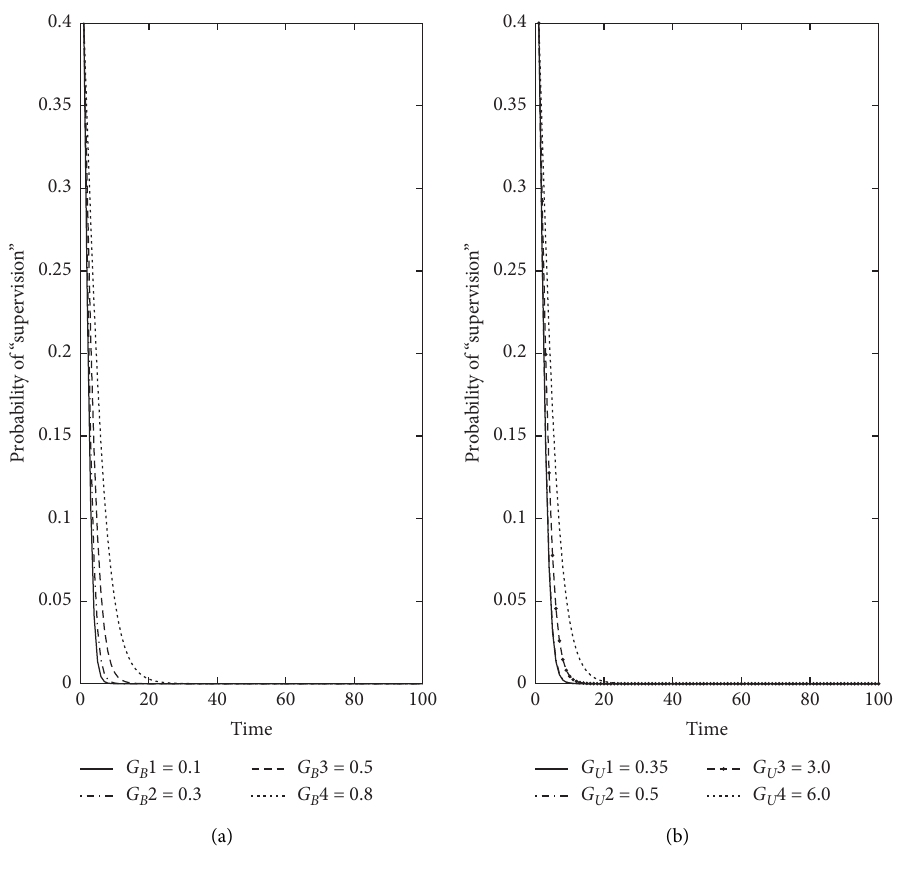
Figure 12: The effects of